Question: Looking at the figure, what chart type is it?
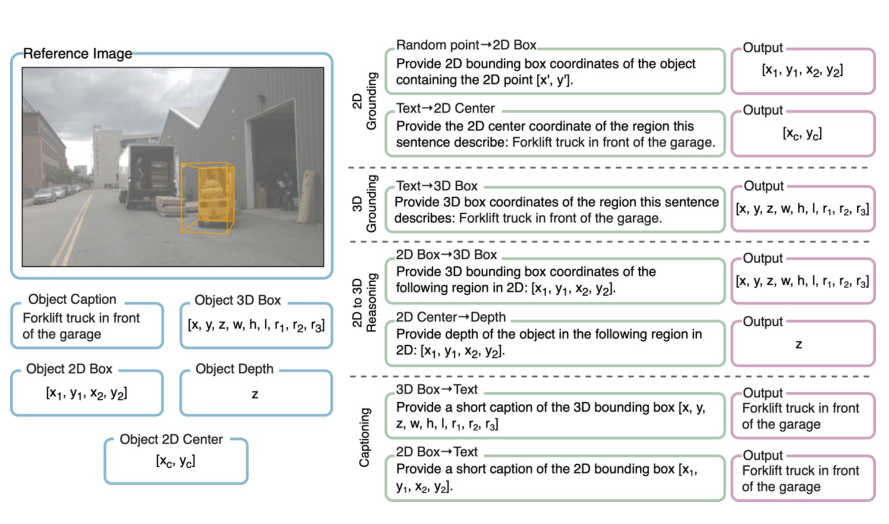
Answer: line